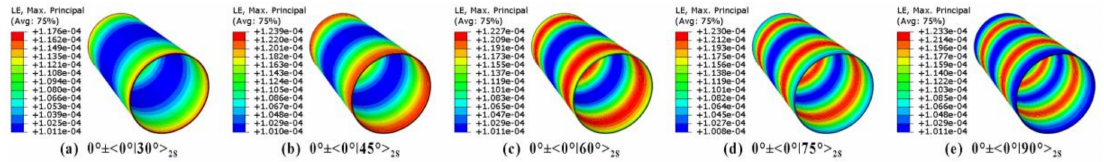
Figure 9. Influence of fiber angle on stress of variable-stiffness composite cylinders.